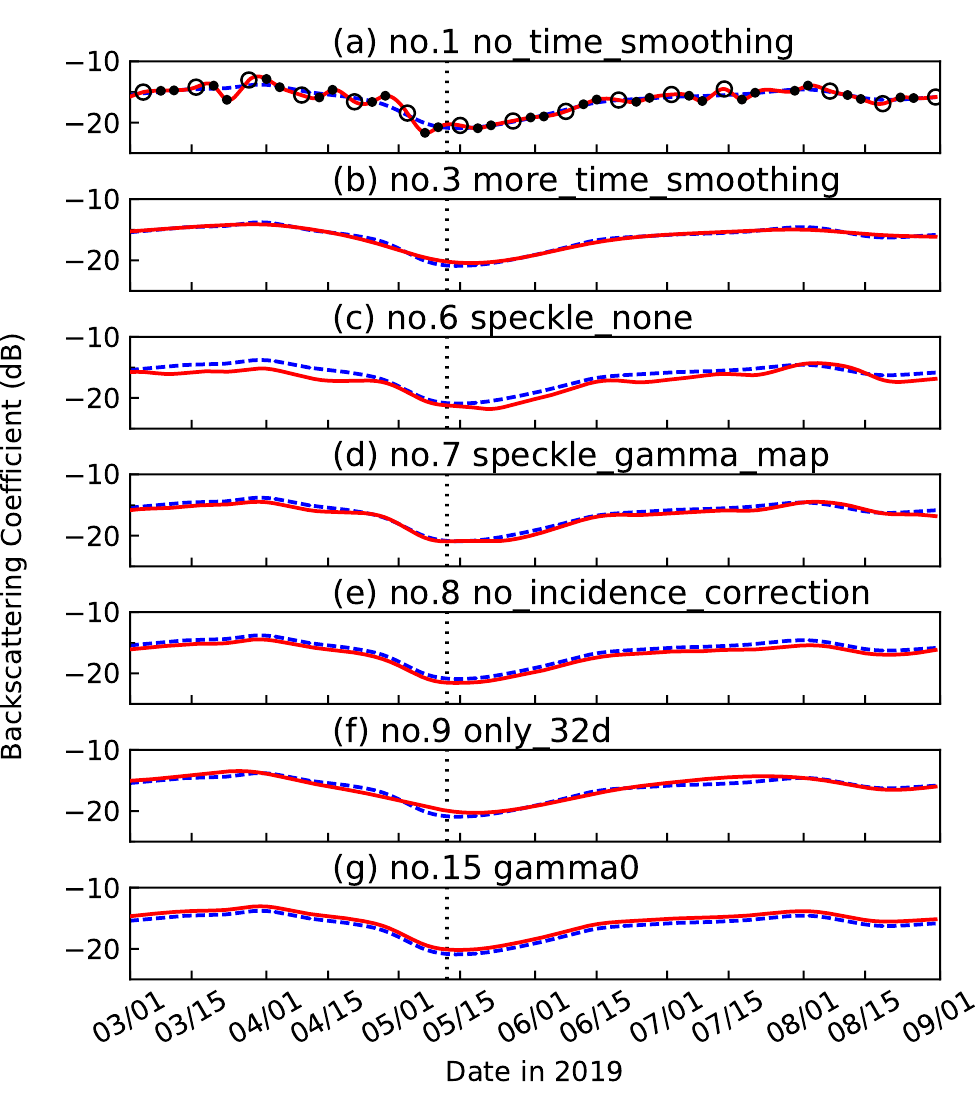
Figure 3. Examples of BSC time-series data. The solid lines in panels ( a – g ) represent the spline interpolation data used in the analysis under settings no. 1, 3, 6, 7, 8, 9, and 15 shown in Table 3, respectively. The dashed lines are the spline interpolation data obtained with the default settings. The white circles in the panel ( a ) indicate the data of the incident angle of 32 ◦ , and the black dots indicate the data with incident angles of 41 ◦ or 45 ◦ before the spline interpolation. The vertical dashed line indicates the transplanting date block value of the target pixel in block